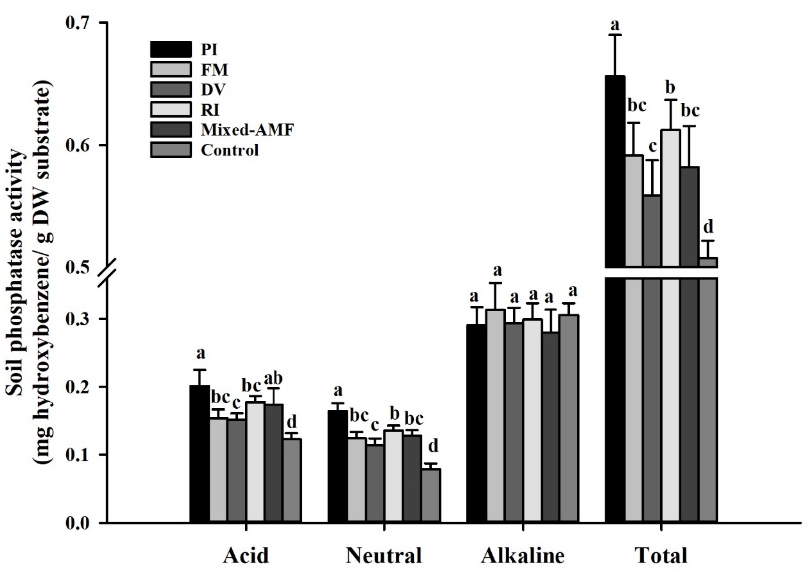
Figure 4. Effects of symbiotic fungi on soil phosphatase activities of Camellia oleifera plants. Data (means ± SD, n = 6) followed by different letters above the bars indicate significant ( p < 0.05) differences. The abbreviation is the same as Table 2.